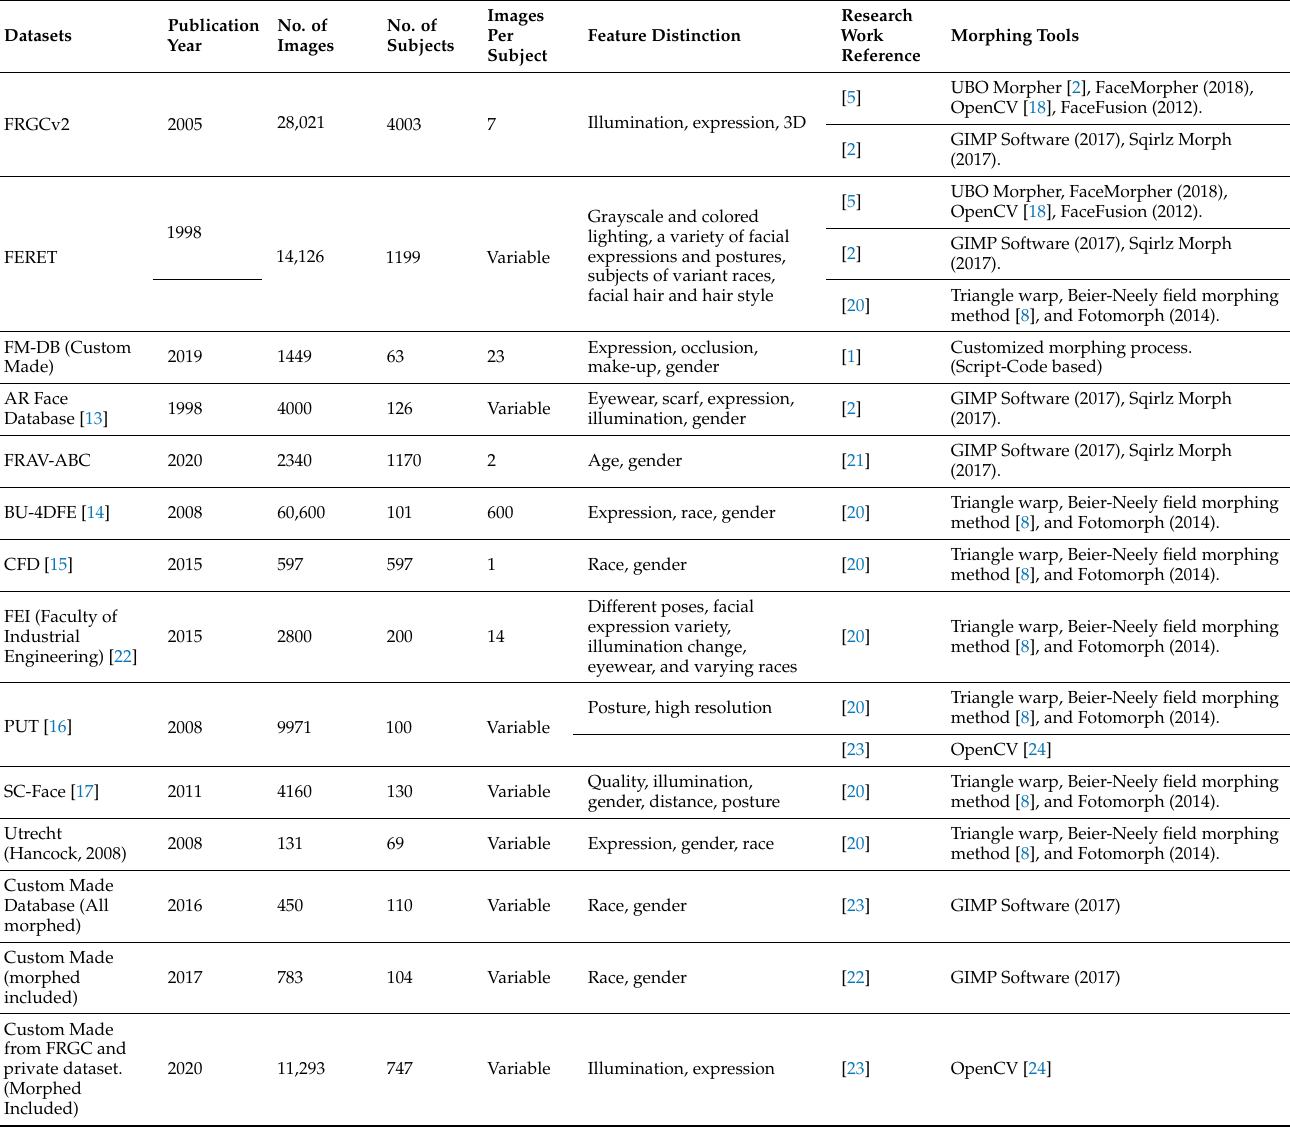
Table 1. Details about source databases and morph attack detection